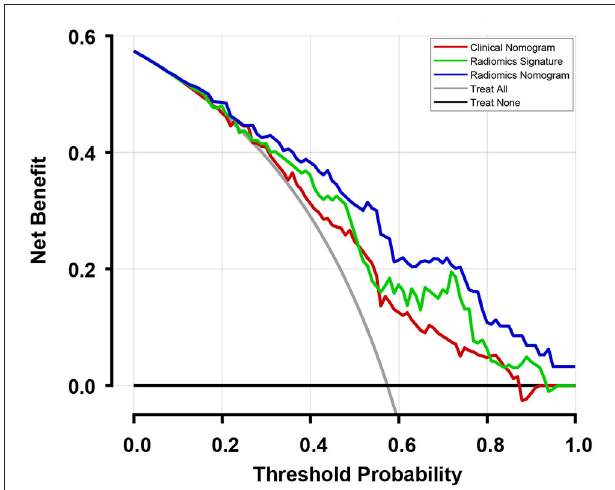
FIGURE 5 | Decision curves of the three models and two extreme curves were plotted based on the validation cohort. When considering the decision curve drawn for different thresholds of probability, patients will add more net benefits when the threshold probability is > 0.10. Therefore, the use of the radiomics nomogram to predict recurrence in patients who achieved pCR has a greater benefit than the use of the radiomics signature and clinical